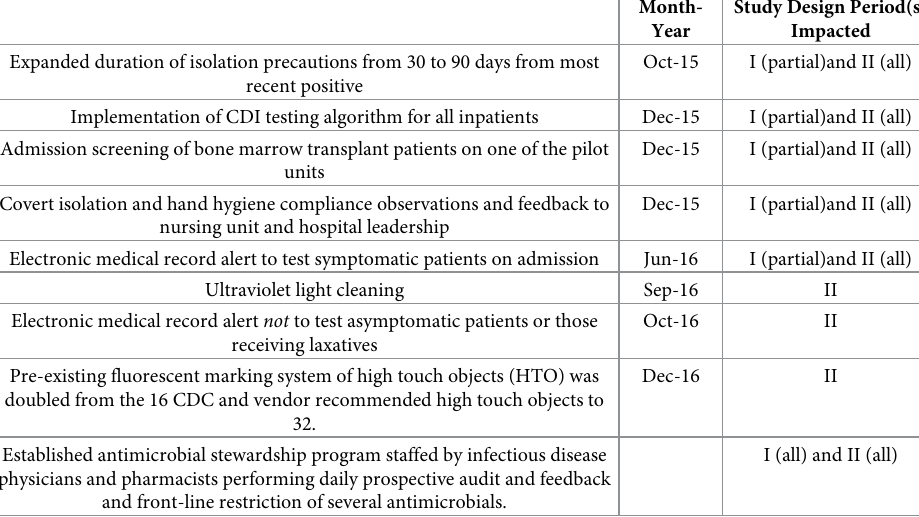
Table 1. Concurrent infection prevention interventions to reduce CDI at UW